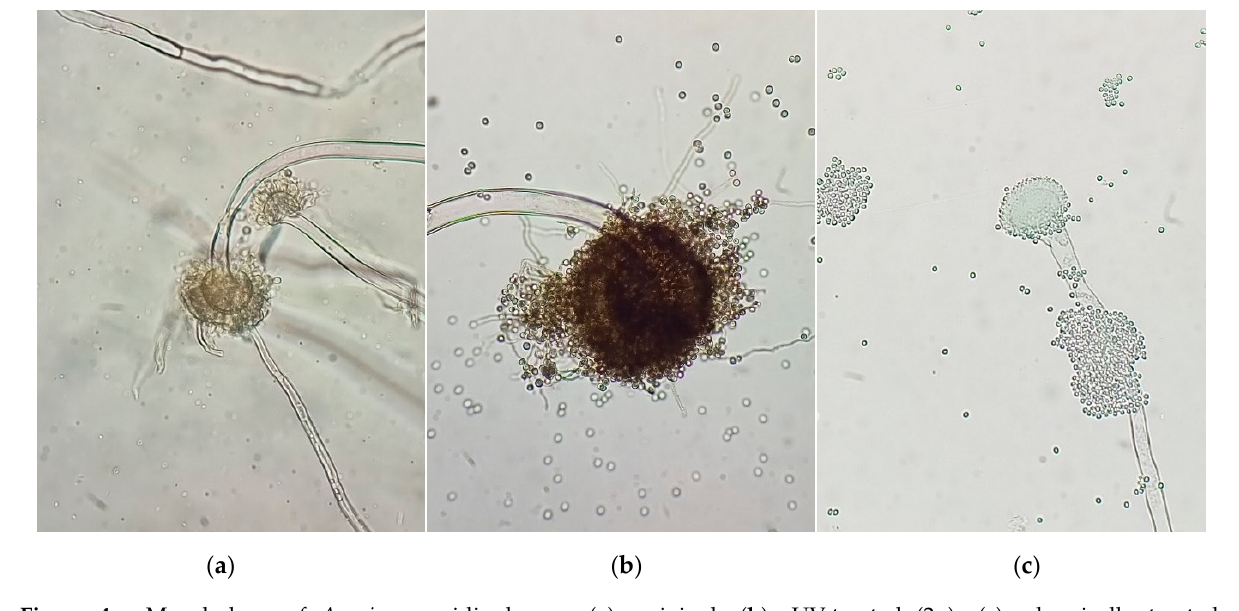
Figure 4. Morphology of A. niger conidiophores : ( a )—original; ( b )—UV-treated (2 ч ); ( c )—chemically treated, (magnification 400×).